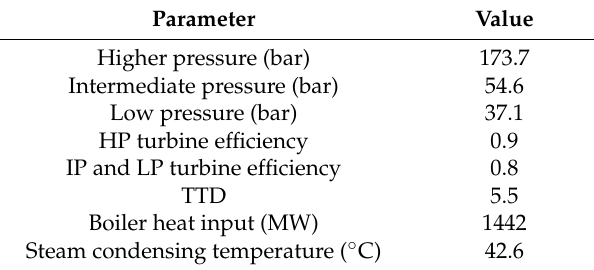
Table 2. Power plant model key input parameters.